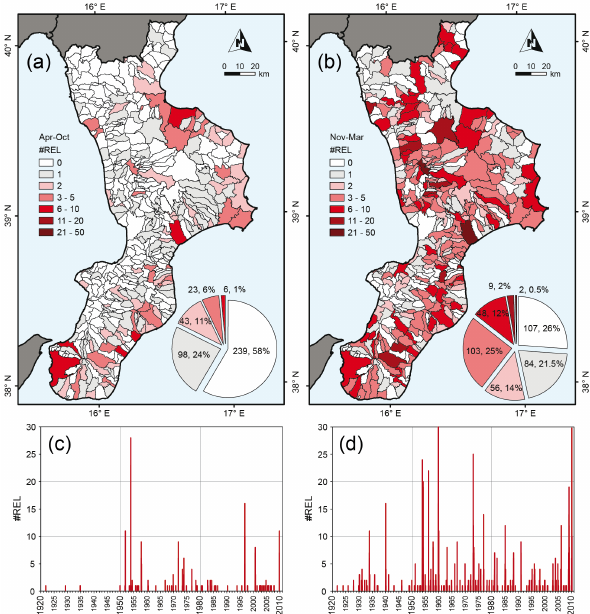
Figure 5. Top: Maps show the number of rainfall events with land- slides (#REL) per municipality in Calabria in (a) the dry period (April to October) and (b) in the wet period (November to March). Pie charts show number and percentage of municipalities in each class. Bottom: Bar charts show temporal distribution of REL in the (c) dry and in the (d) wet